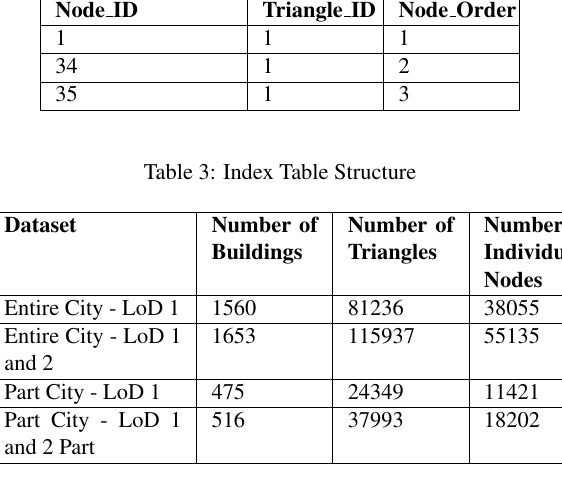
Table 4: Pre-Triangulated Data Structure, Optimised for Visuali- sation